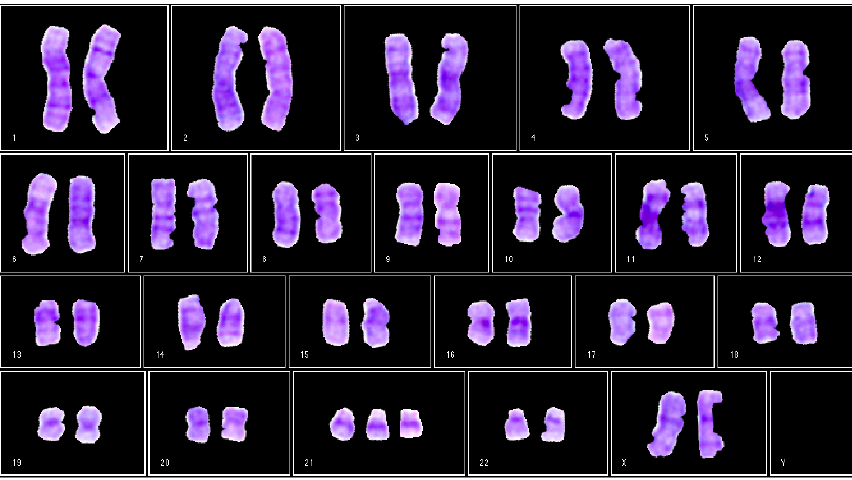
Figure 2. Obtained Karyogram from the classified chromosomes (karyotype) in Figure